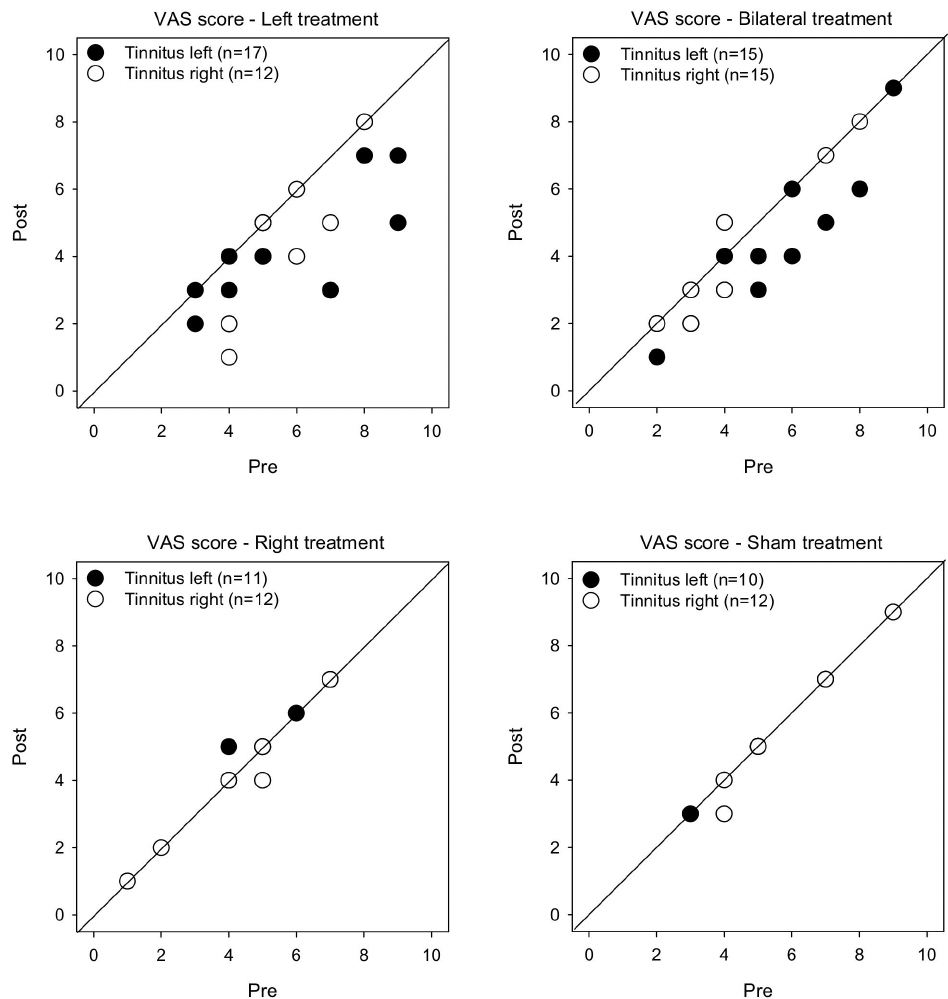
Figure 1. Post-treatment VAS scores as a function of pre-treatment scores for the Left, Right, Bilateral and Sham treatment groups. The filled and open symbols show data for patients with left- or right-sided tinnitus, respectively. Values below the diagonal line indicate reduced VAS scores after